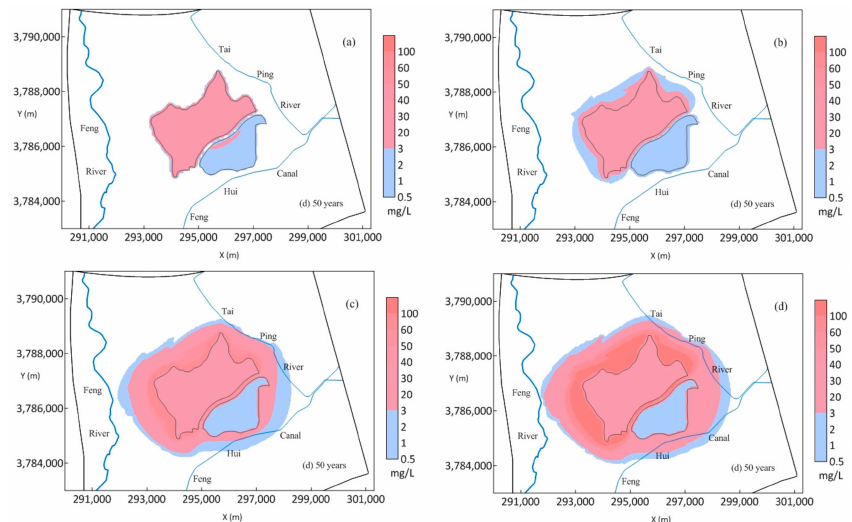
Figure 13. COD transport of ( a ) 3 years; ( b ) 10 years; ( c ) 20 years; ( d ) 50 years after water storage in